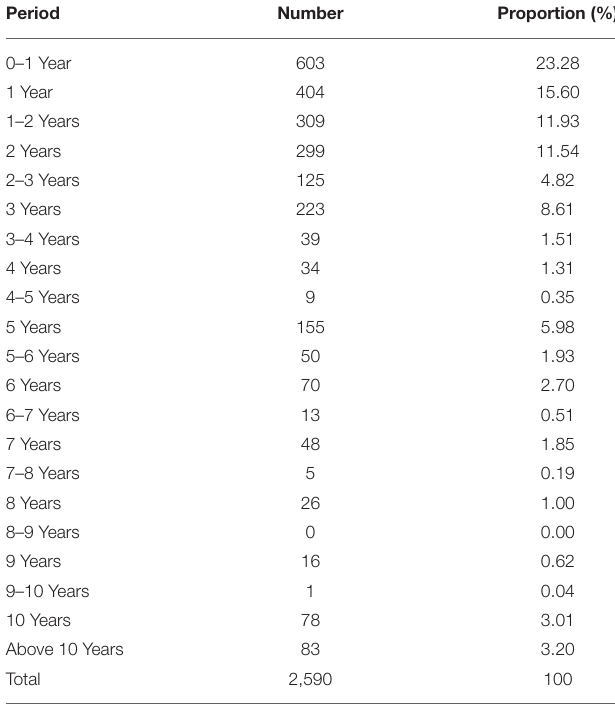
TABLE 5 | The distribution of the sentencing